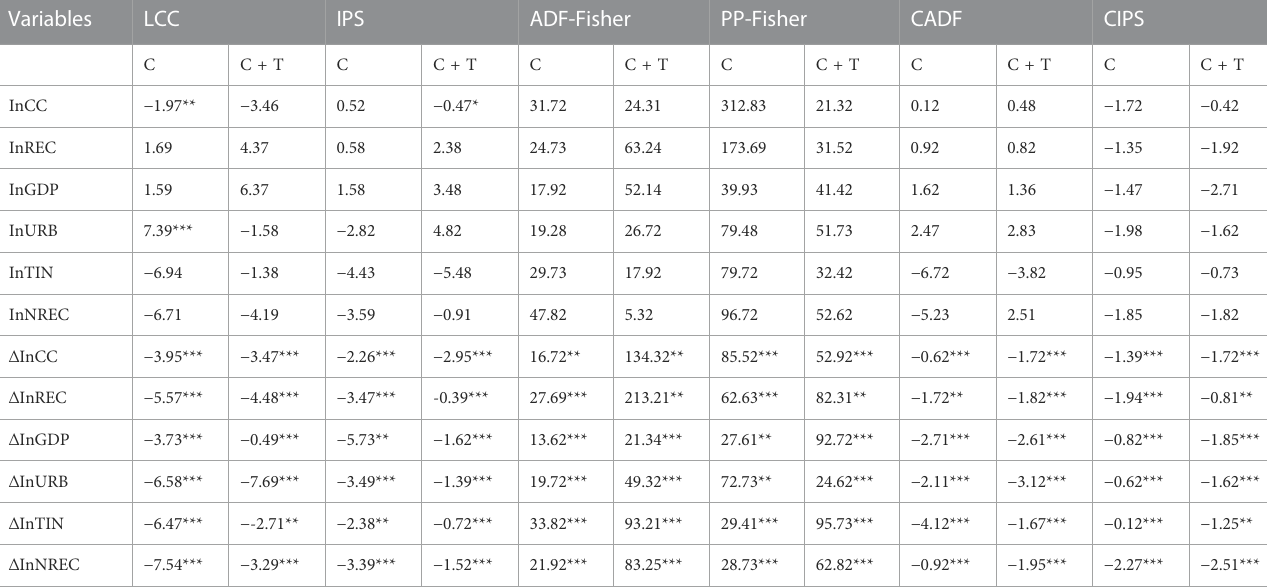
TABLE 3 Results of the panel unit root tests.